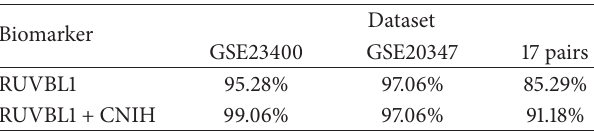
Table 1: Classification accuracies using biomarkers of RUVBL1 and